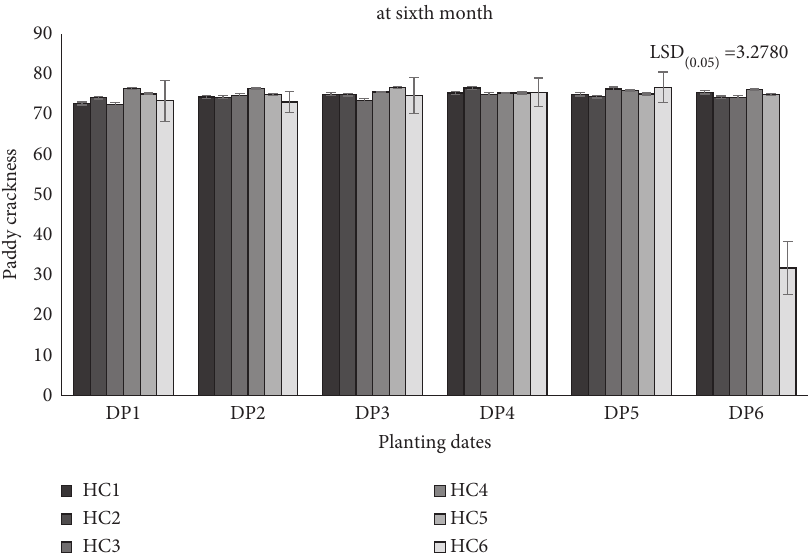
Figure 10: Effect of planting date and harvest cycle on paddy cracking at six months of storage in the Northern Savanna Agroecological Zone of Ghana. Bars represent the SEM. DP1 � first planting, DP2 � second planting, DP3 � third planting, DP4 � fourth planting, DP5 � fifth planting, DP6 � sixth planting, V1 � Agra, V2 � Gbewaa, V3 � Exbaika, V4 � Perfume Irrigated, HC1 � first harvest, HC2 � second harvest, HC3 � third harvest, HC4 � fourth harvest, HC5 � fifth harvest, and HC6 � sixth